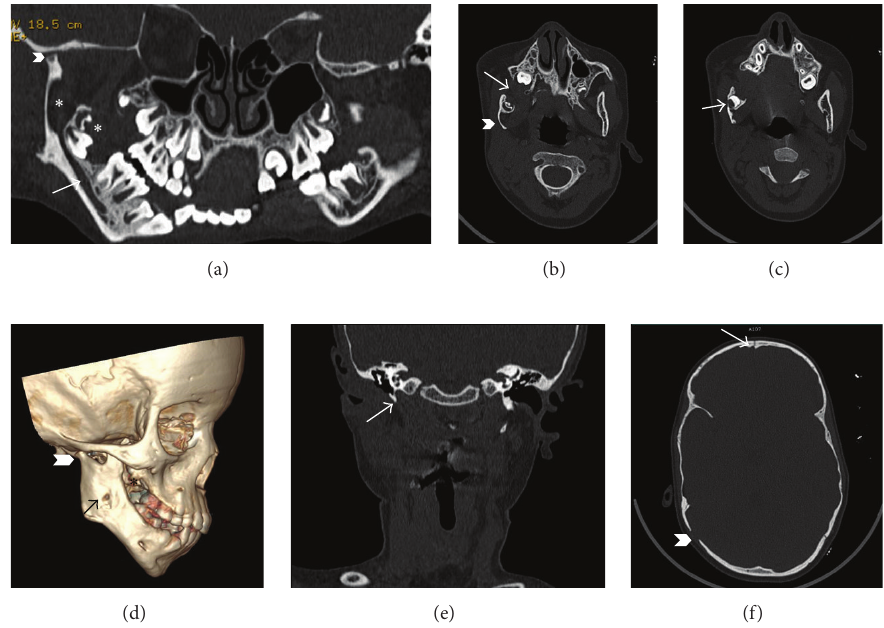
Figure 4: (a) Panoramic dental scan depicting enlarged inferior alveolar canal (arrow) with residual tumor mass (asterisk) and hypoplastic condylar process (chevron), (b) axial CT in bone window showing the residual mass in alveolar margins of maxilla and mandible (arrow) and concavity of mandibular ramus (chevron), (c) axial CT scan showing apparent foramen (arrow) due to lytic erosion of mandibular cortex, (d) 3D CT scan image showing hypoplastic condylar process (chevron), apparent foramen (arrow), and tumor in maxillary alveolus (asterisk), (e) coronal CT image showing rudimentary styloid process of right side (arrow), and (f) axial CT image of sutural diastasis (chevron) and persistent metopic suture